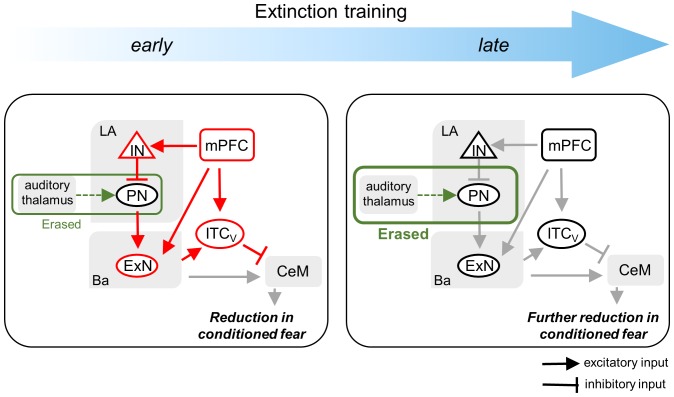
Schematic diagram for the changes in extinction mechanisms as extinction training proceeds.Please note that green and red lines represent the inhibition and erasure mechanisms, respectively. As extinction training proceeds from the early to the late phase, the inhibition mechanism disappears whereas the erasure mechanism persists. The erasure mechanism at the early phase is depicted as smaller than at the late phase in order to show that relative contribution of the erasure mechanism to extinction is less at the early phase than at the late phase.